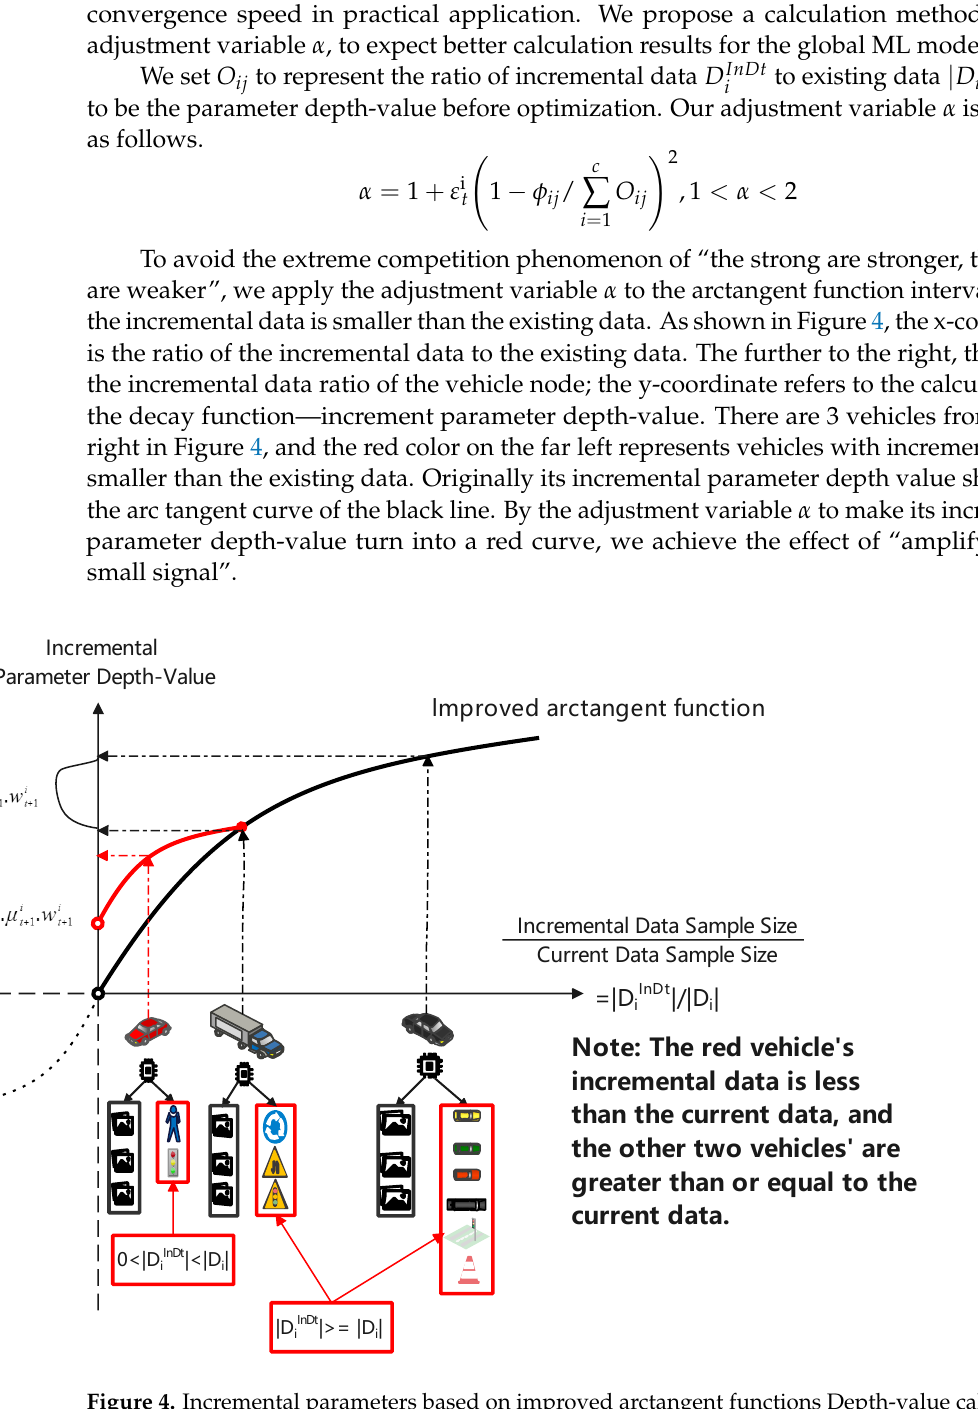
Figure 4. Incremental parameters based on improved arctangent functions Depth-value